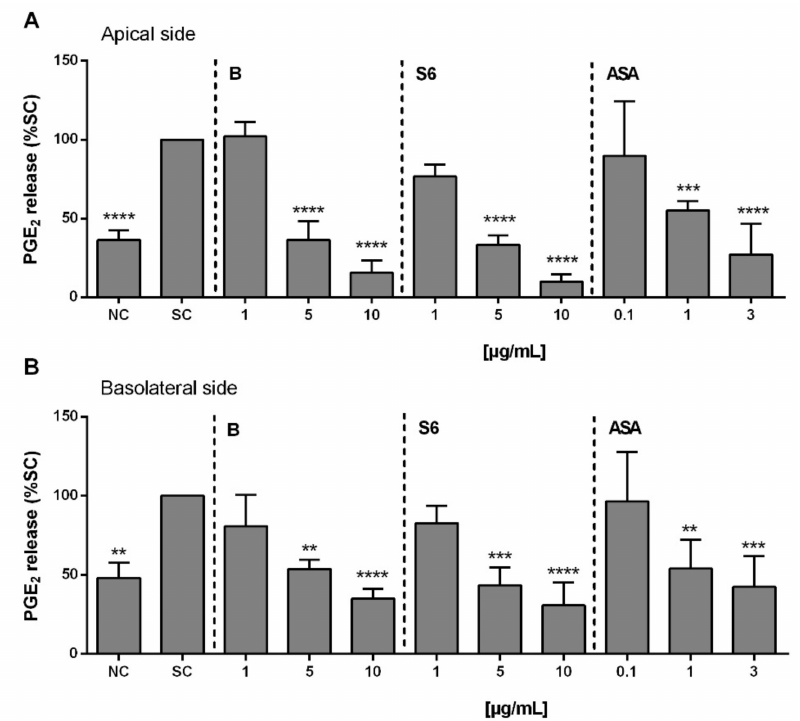
Figure 4. The effects of Salix extracts and ASA on the inhibition of PGE 2 release from activated Caco2/HT29-MTX co-culture. After 19–21 d of co-culture, the cells were pre-treated with Salix extracts or ASA for 30 min before activation for 24 h with IL-1 β (25 ng/mL), IFN- γ (50 ng/mL), TNF- α (50 ng/mL), and LPS (1 µ g/mL). The amount of PGE 2 in supernatant of the ( A ) apical side and ( B ) basolateral sides was quantified using an ELISA kit. NC: cells only. SC: 1% distilled water in activated cells. Bars are the